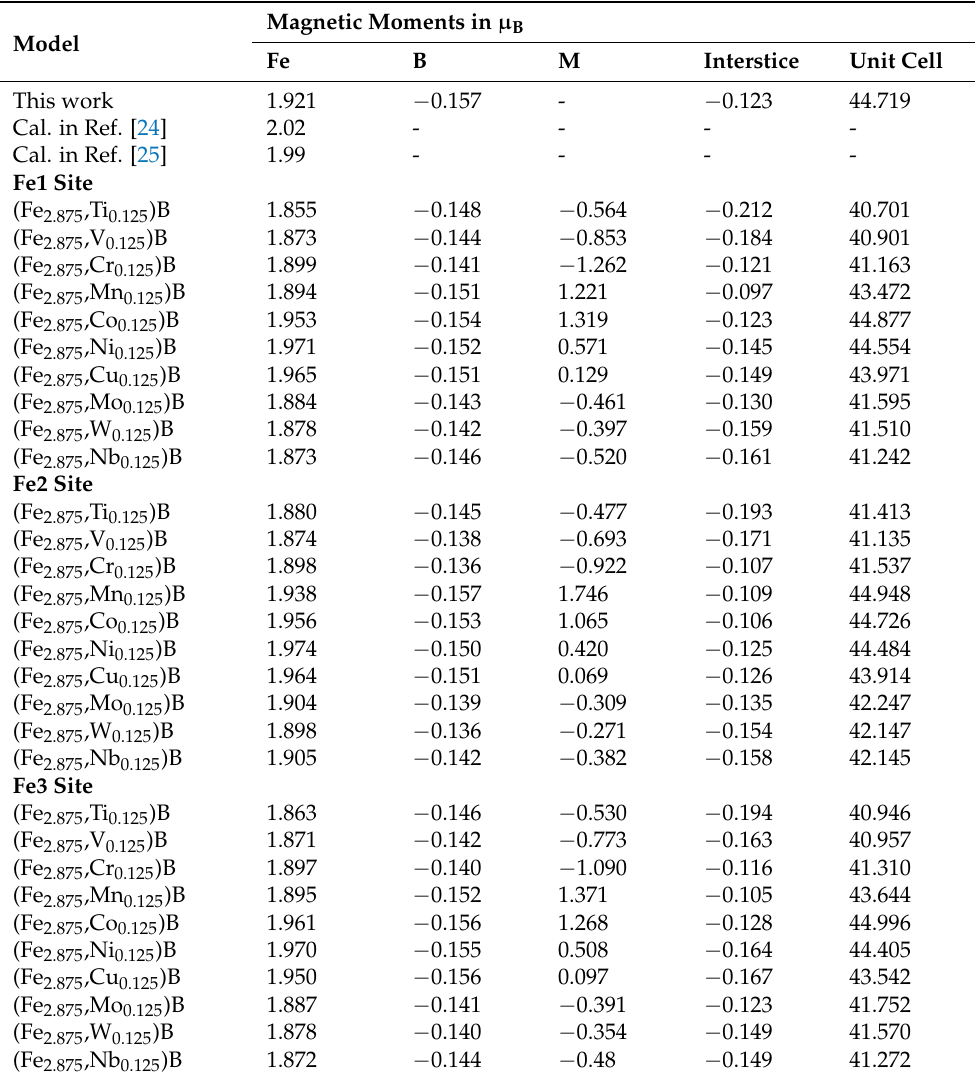
Table 3. Average magnetic moments of Fe atom, B atom, alloying elements M, interstitial region and unit cell for Fe 3 B and alloyed Fe 3 B.